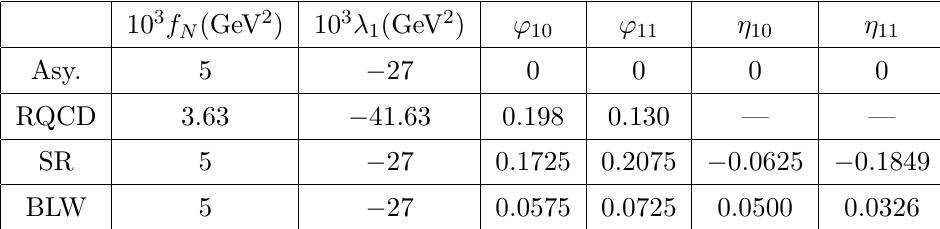
Table 1. List of different estimates for the parameters f N , λ 1 , ϕ 10 , ϕ 11 , η 10 and η 11 . The values are presented at the renormalization scale µ 2 = 1 GeV 2 by using one-loop evolution. The errors are not shown here. The values of asymptotic (Asy.) model and QCD sum-rule (SR) estimate are taken from ref. [98]. Especially, it is well-known that the parameters here are related to the local quark-gluon operators which the QCD sum-rule methods can be applied in refs. [81, 93–98, 111, 112]. The Braun-Lenz-Wittman (BLW) model is also shown here [98]. This model is based on the light-cone sum-rule analysis on the nucleon electromagnetic form factors which results in a relation between the electromagnetic form factors and the nucleon twist-3 and twist-4 DAs. With the choice of specific values, a good description for the experimental data was obtained. Furthermore, the parameters have been estimated in the lattice QCD simulations [99–104] and the updated values evaluated by RQCD collaboration are adopted